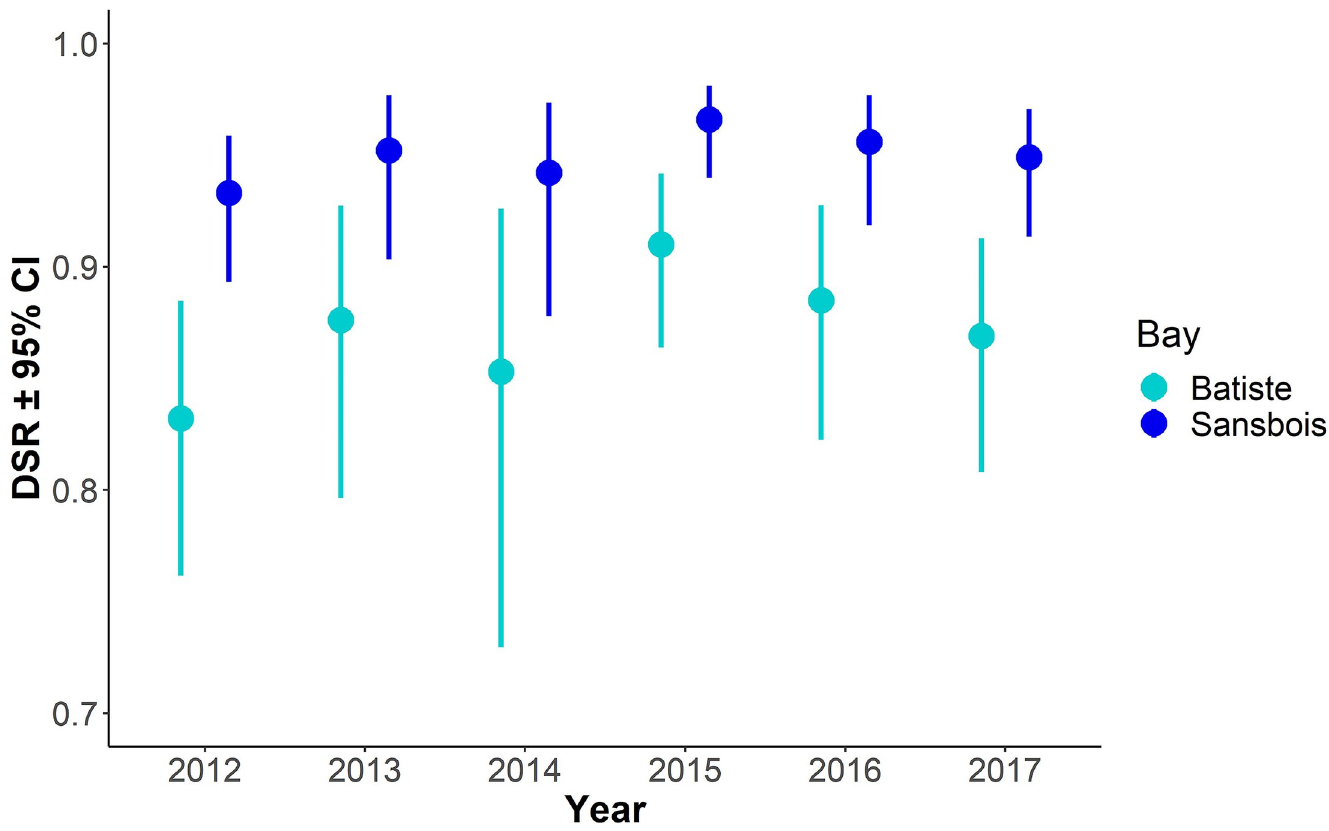
Fig 3. Mean estimated nest daily survival rates (DSR ± 95% confidence intervals) of Seaside Sparrows derived from a logistic exposure model in two bays during 2012–2017 in Louisiana, USA. DSR estimates are from a model including only Year and Bay.